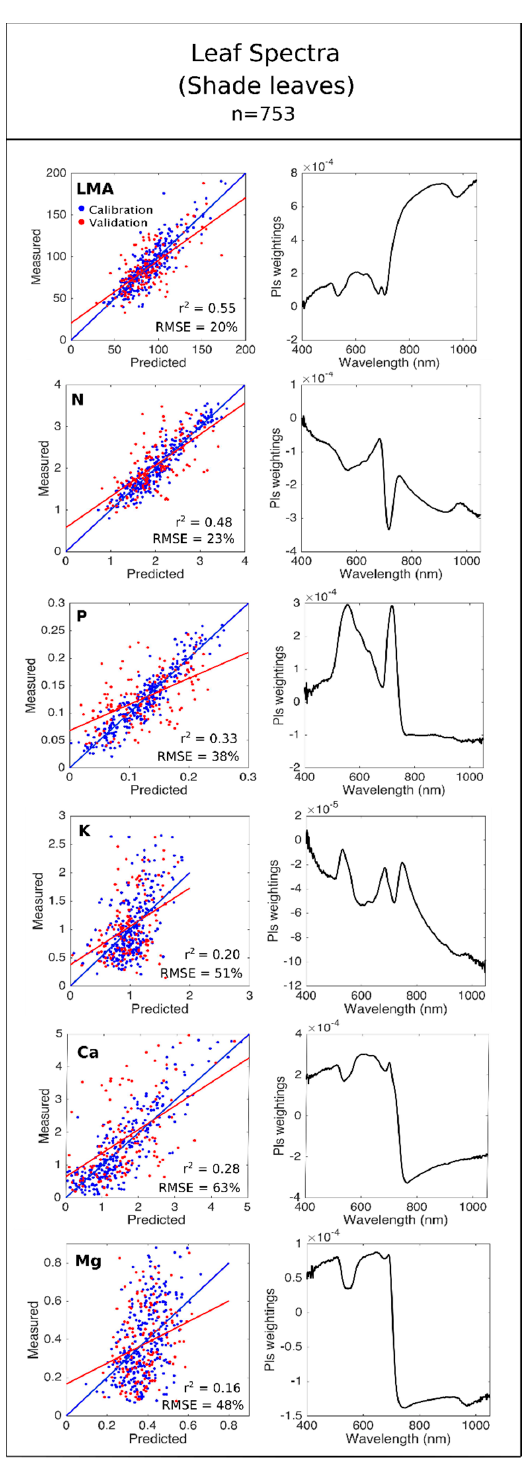
Figure A1. ( left ) Relationships between measured and predicted leaf traits using shade leaf reflectance spectra from Figure 2 and PLS regression analysis. n = 753. Blue line = r 2 -cal regression line. Red line = r 2 -val regression line. RMSE and r 2 -cal values displayed on graph. ( right ) PLSR spectral weightings for each leaf trait. Deviation from 0 indicates the parts of the spectrum that most strongly influence the empirical